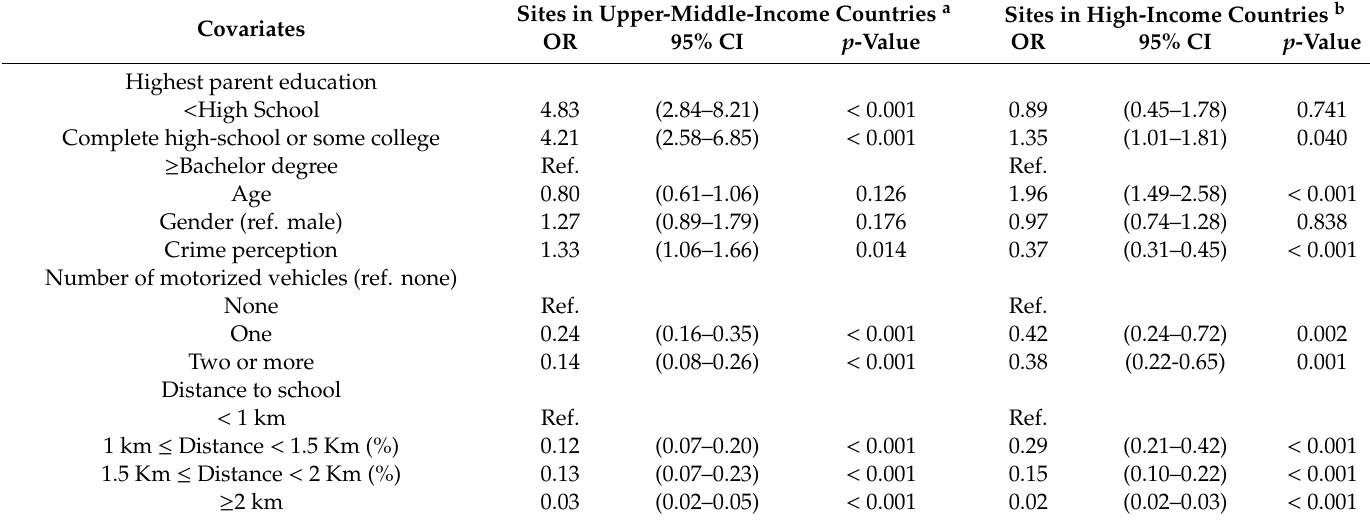
Table 3. Factors associated to active school transport in 2845 9–11-year-old children, by income level of the